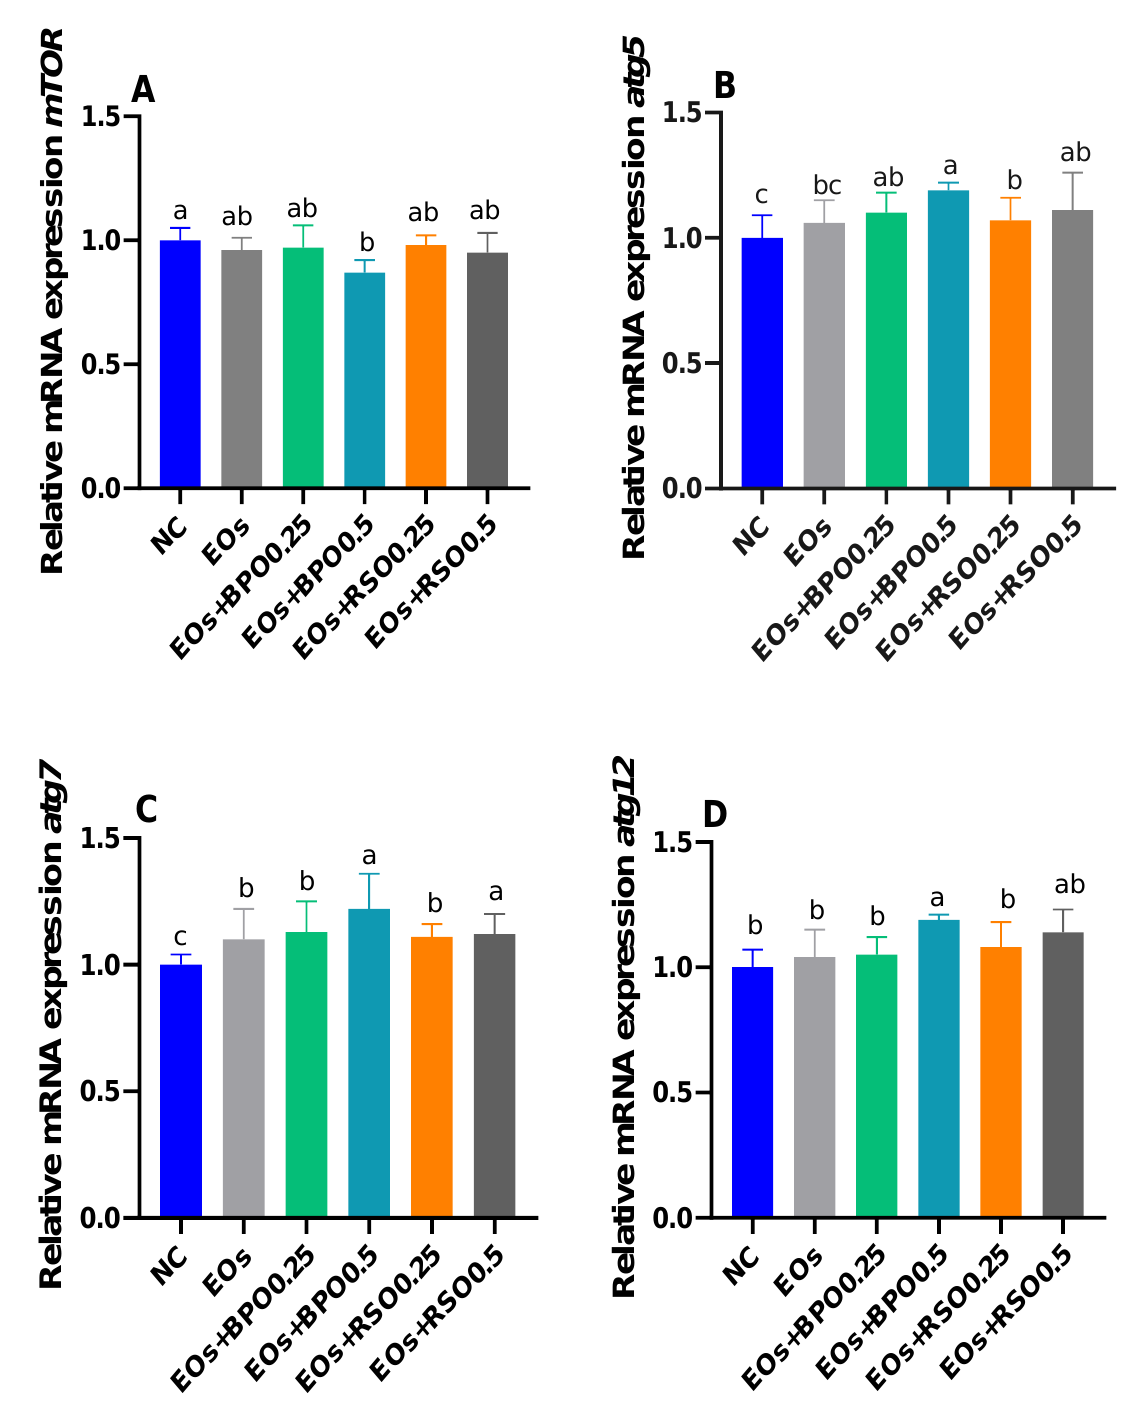
Figure 4. Effect of EOs with black pepper oil or radish seeds oil on mRNA expression of mecha- nistic target of rapamycin (mTOR, ( A )) and autophagy-related genes ( atg5 , atg7 , and atg12 shown in ( B – D ), respectively) genes; abcd means within the same column carrying different superscripts are significantly different at ( p < 0.05). EOs mixture of mint, parsley, and carrot oils. NC: feed basal diet without additives; EOs: birds fed a basal diet supplemented with 1.5 g/kg EOs; EOs + BPO0.25: birds fed a basal diet supplemented with 1.5 g/kg EOs plus 0.25 g/kg black pepper oil (BPO); EOs + BPO0.5: birds fed a basal diet supplemented with 1.5 g/kg EOs plus 0.25 g/kg black pepper oil (BPO); EOs + RSO0.25: birds fed a basal diet supplemented with 1.5 g/kg EOs plus 0.25 g/kg radish seed oil (RSO); EOs + RSO0.5: birds fed a basal diet supplemented with 1.5 g/kg EOs plus 0.5 g/kg radish seed oil